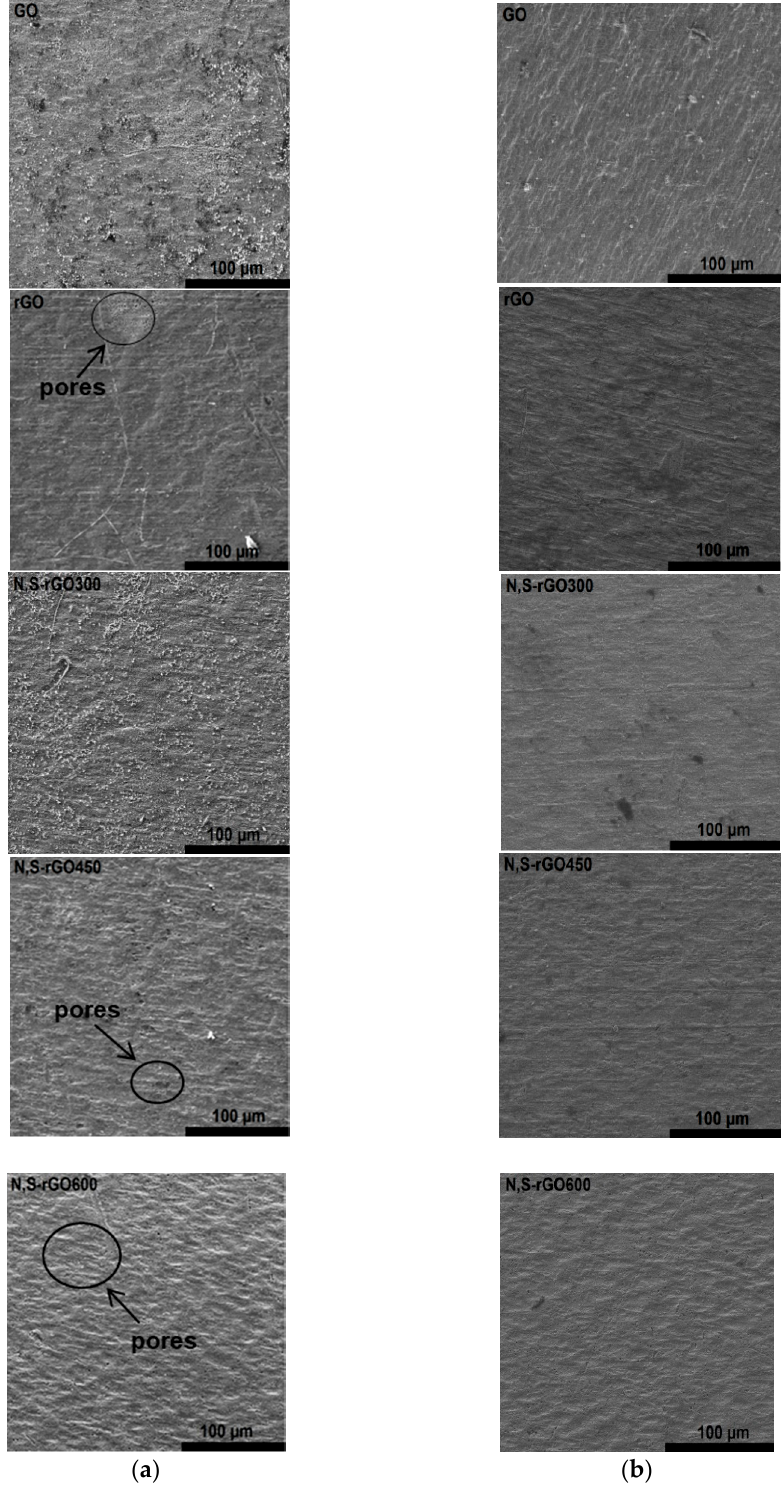
Figure 6. Scanning Electron Microscope (SEM) images for graphene coatings: ( a ) before corrosion test; ( b ) after corrosion test.